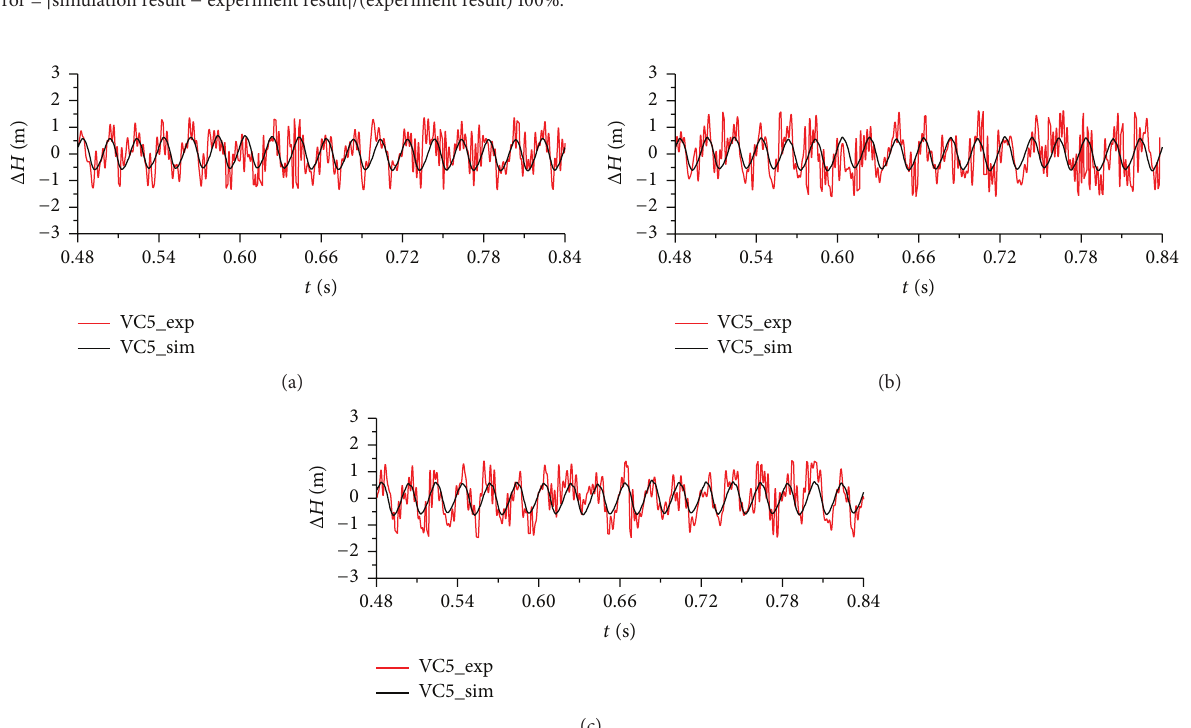
Pressure fluctuation data obtained by the numerical simulations and model test are compared for M1, M2 and